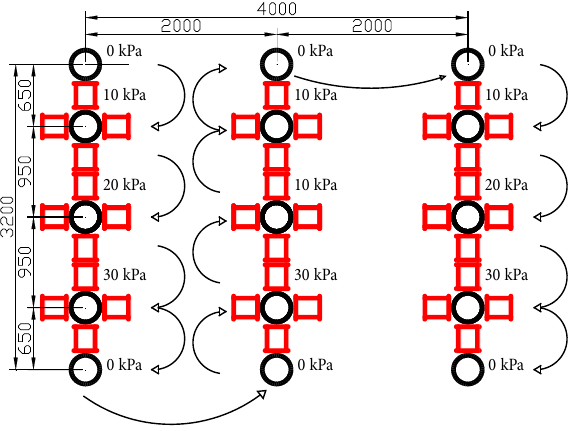
Fig. 5. Experiment plan (distances in mm)